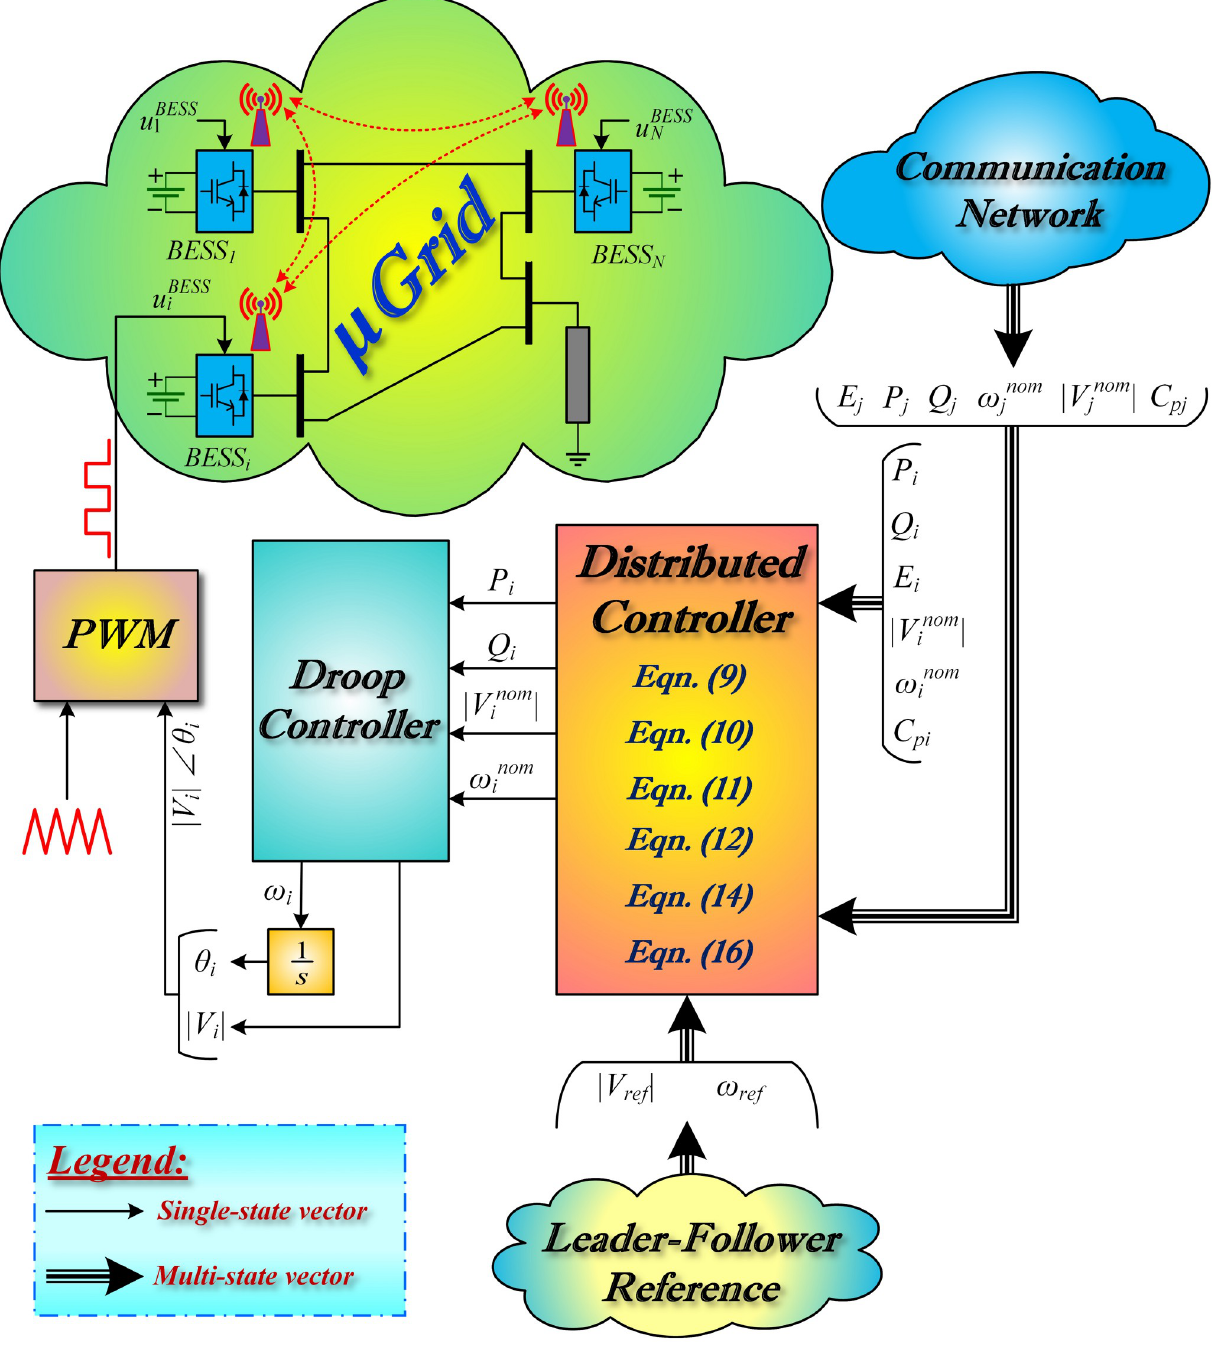
Fig 1. Closed-loop BESS model with leader-follower consensus